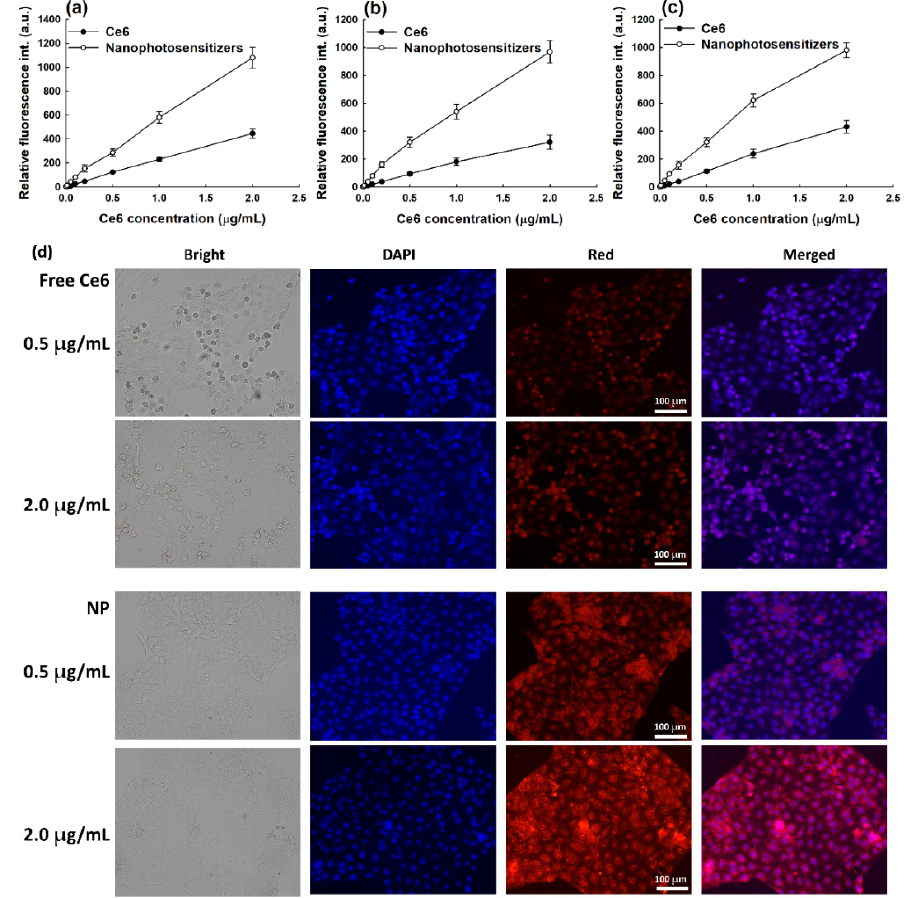
Figure 9. Intracellular Ce6 accumulation by treatment of Ce6 or nanophotosensitizers. ( a ) YD-38 cells. ( b ) KB cells. ( c ) SCC-15 cells. The results are the average ± standard deviation (s.d.) from eight different experiments. ( d ) Fluorescence observation of YD-38 cells after treatment of Ce6 and nanophotosensitizers. Relative fluorescence int. (a.u.) = Relative fluorescence intensity (arbitrary units). Bar = 100 μ m. Magnification = 200×.